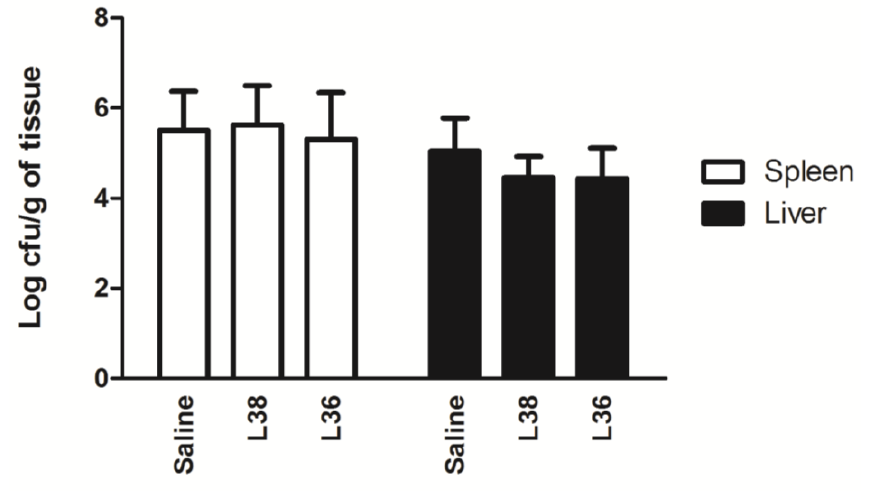
Figure 4. Translocation of Salmonella Typhimurium to liver and spleen of L38- and L36-treated mice on the 9th day post -Salmonella challenge. The bacterial counts are expressed as mean log cfu/g organ ( n = 10 per group). The vertical bars indicate the standard deviation of means. No letters over the bars indicate no statistically differences between the experimental groups ( p >